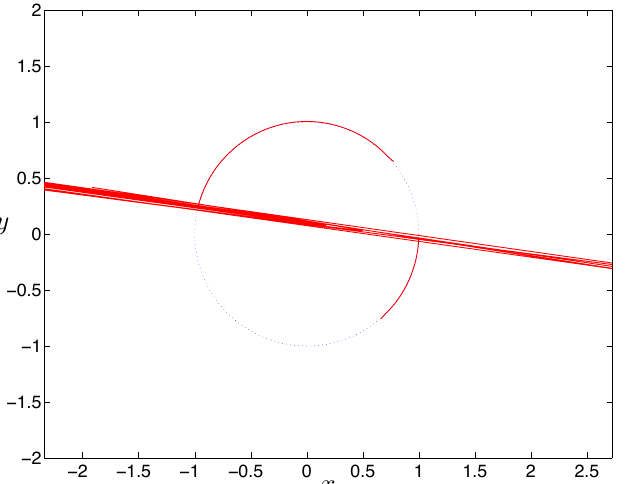
Figure 8. Bohmian trajectory for an exact solution [91]. It starts in the asymptotic past in the neighborhood of the critical point ( 1/ √ 2, 1/ √ 2 ) , and it ends in the asymptotic future in the − neighborhood of the critical point ( 1/ √ 2,1/ √ 2 ) . Classical dynamics is valid almost everywhere, except near the singularity, where quantum effects become important and a bounce takes place. Note that the classical constraint x 2 + y 2 = 1 ceases to be satisfied in the quantum